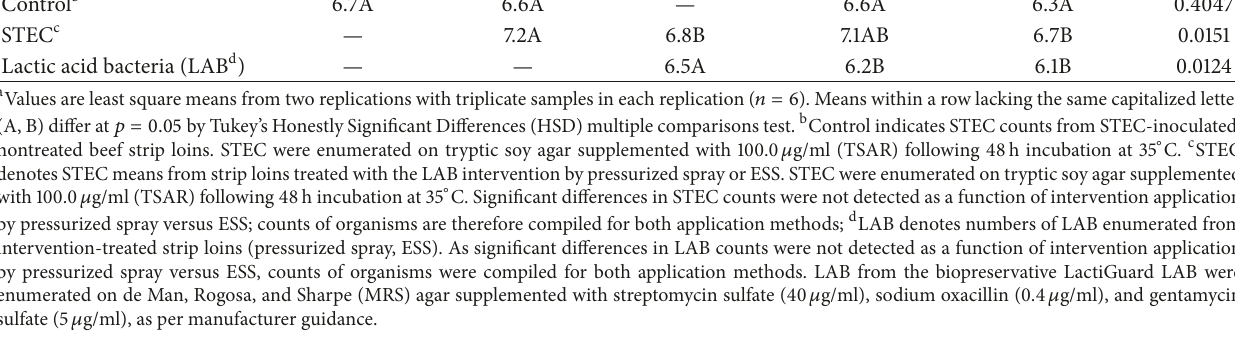
Table 2: Least squares means of bacterial populations on beef strip loins (log 10 CFU/cm 2 ) treated with lab and vacuum aged at 4 ∘ C. Target